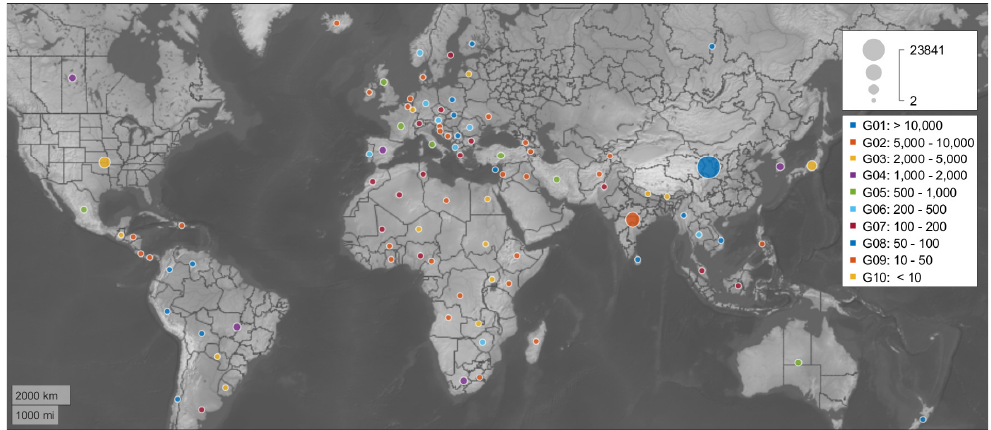
Figure 1. Global distribution of large dams as of